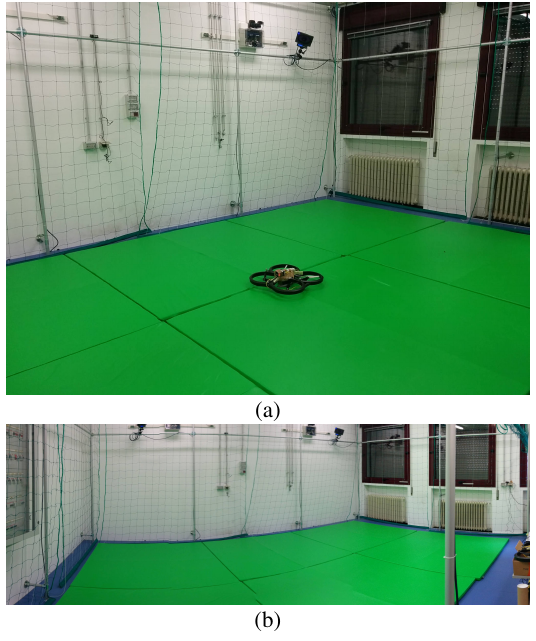
Figure 1. The considered UAV (a), and a panoramic view of the flying arena